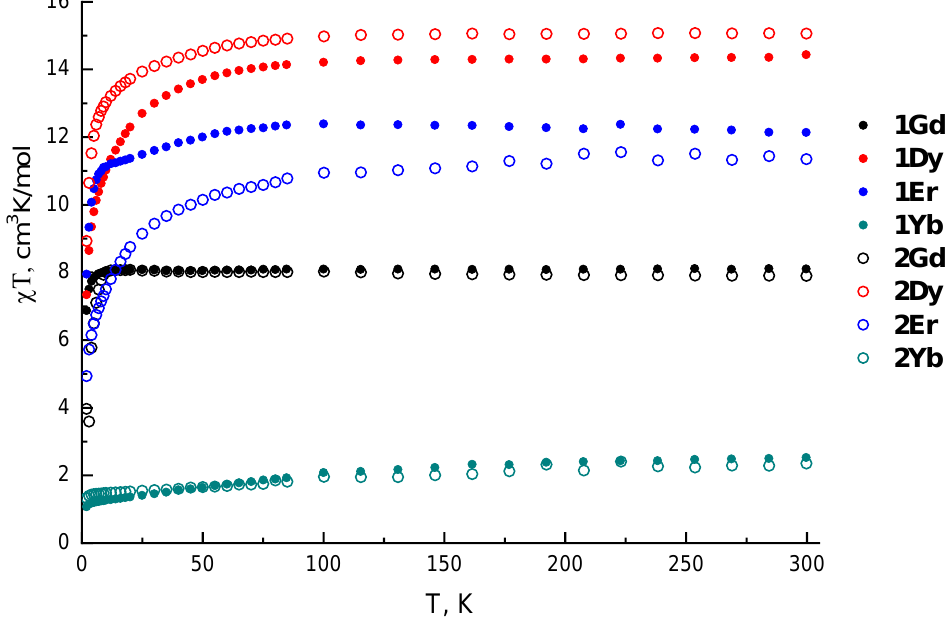
Figure 2. χ T vs. T dependences for the studied complexes in 5000 Oe DC field. Figure 2. χT v s. T dependences for the studied complexes in 5000 Oe DC field. Table 1. χ T values (cm 3 · mol − 1 · K) for the complexes at 300 and at 2 K. Table 1. χT values ( cm 3 ·mol − 1 ·K) for the complexes at 300 and at 2 K.